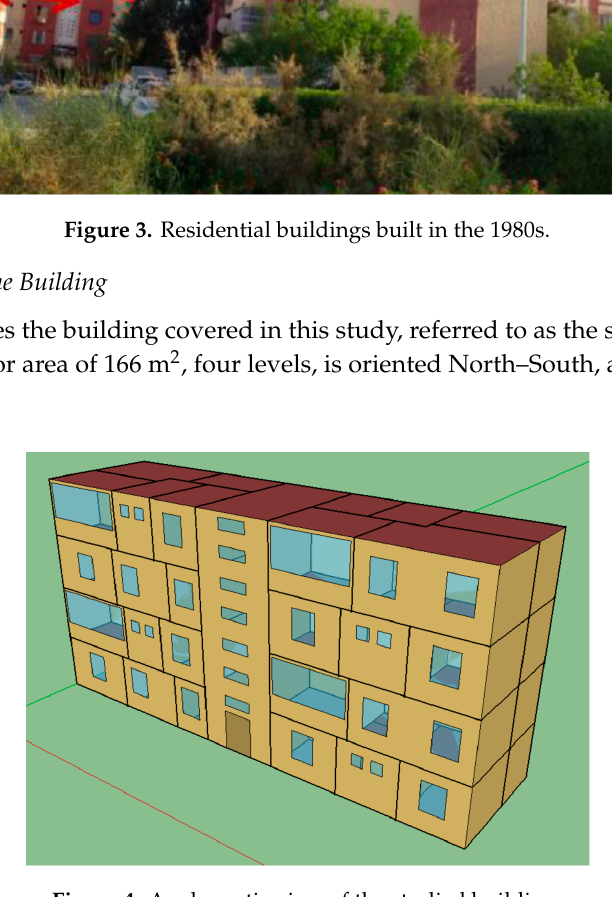
Figure 4. A schematic view of the studied building.